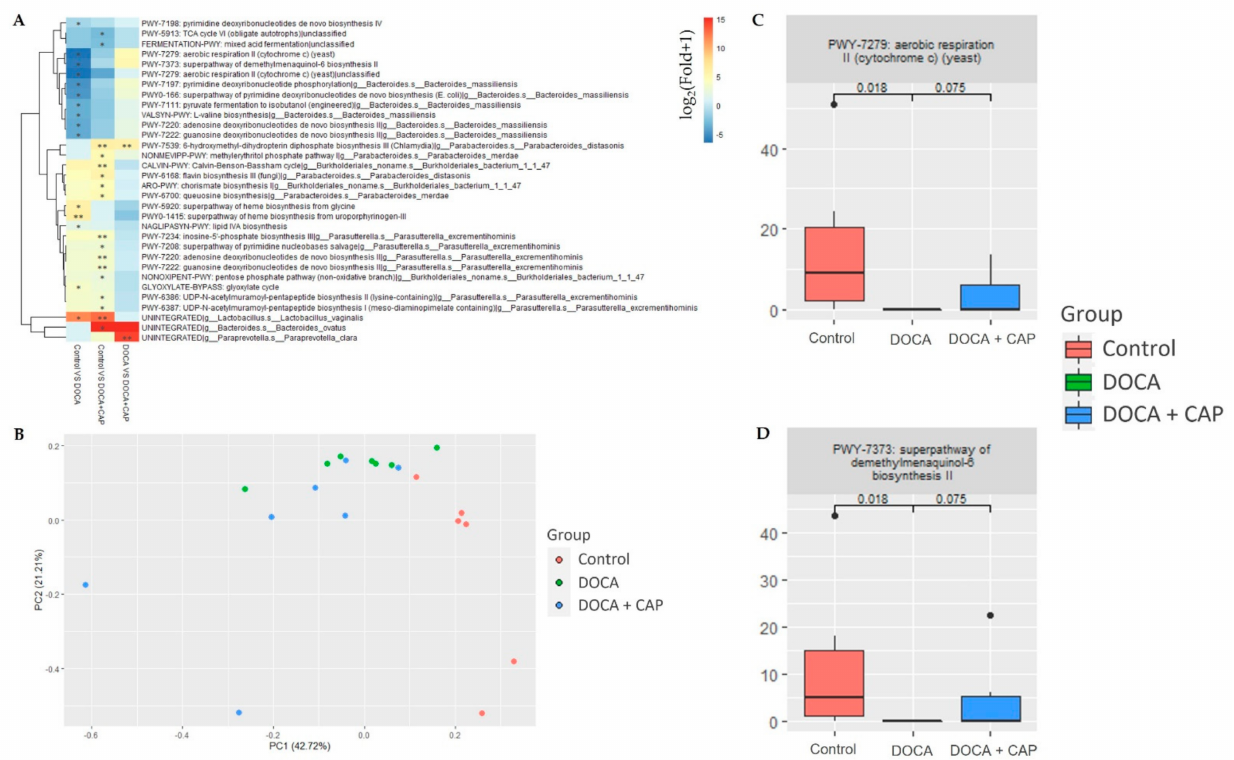
Figure 6. ( A ) Heatmap of the log-fold-change of the top 32 differentially expressed pathways identified from the taxonclassified sequences from gut bacterial shotgun metagenomic sequencing among the Control, DOCA, and DOCA + Captopril groups. ( B ) The plot of the first 2 principal components (PCs) of the 32 identified bacterial pathways, with the first PC explaining 18% variance and the second PC explaining 12% variance. ( C , D ) Box plots demonstrate the expression of the 2 identified bacterial pathways in each group with the p -values of the group comparison reported. (* p < 0.05, ** p <